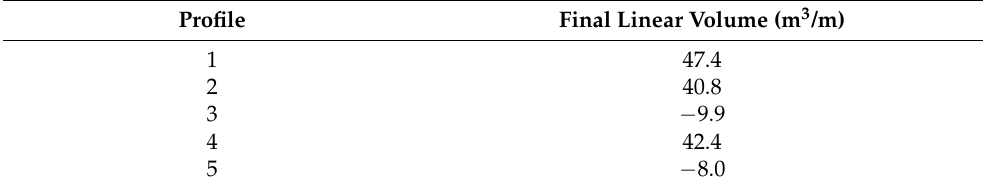
Figure 3. Topographic comparison of the five topographic profiles (see the location in Figure 1), between 2004 and 2013. Distance is measured from the landside limit of the dune system to the bare beach. Three to five dune ridges are observed in each, the most active being the secondary dune (S) at ca. 65 m., the primary dune (P) at 75 m, and the embryonic dune (E) at 90 m. Both the primary dune (P) and the embryonic dune (E) have originated during these almost 10 years of regeneration measures. Table 1. Volumetric changes, in cubic meters per linear meter (m 3 /m), in the profiles between 2004 and